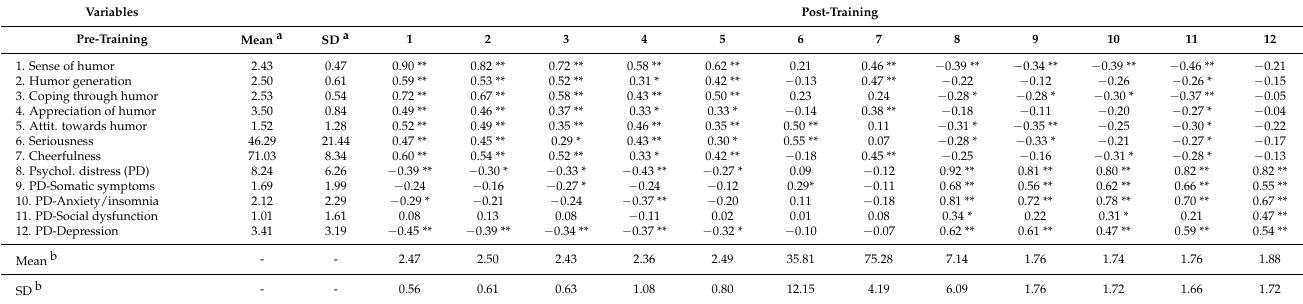
Table 2. Means, standard deviations, and bivariate correlations among the main variables of the study ( n = 58). Variables Post-Training